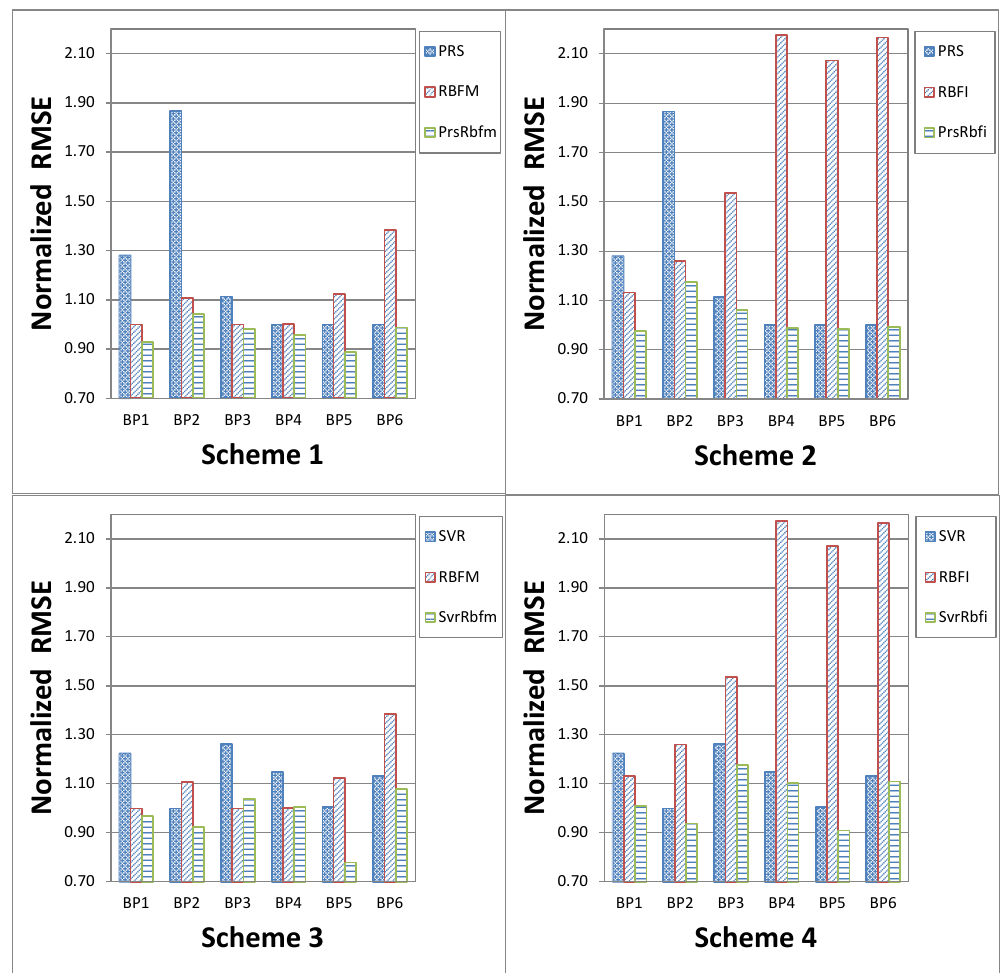
Figure 3. Normalized means of RMSE of each ensemble scheme for the six benchmark problems with 3 ( k + 1 )( k + 2 ) training 2